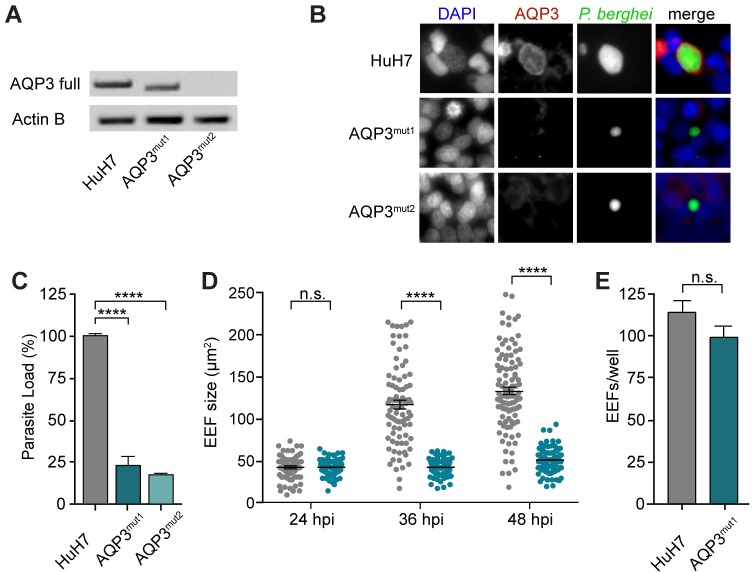
AQP3mut cells prevent the proper development of P. berghei exo-erythrocytic forms.(A) Full length AQP3 transcript PCR amplification of RNA collected from wild type HuH7 cells and AQP3 mutated cell lines produced by CRISPR/Cas9 genome editing, AQP3mut1 and AQP3mut2. A truncated AQP3 transcript was amplified in AQP3mut1 while AQP3mut2 did not produce any AQP3 mRNA. (B) AQP3 protein was not detected by immunostaining in AQP3mut1 or AQP3mut2 cell lines at 48 hpi. Images of cells infected with P. berghei and stained for PbHsp70 (green), HsAQP3 (red), and DAPI (blue). (C) Parasite load in AQP3mut1 and AQP3mut2 cells was significantly decreased by 77 ± 4.7% and 82 ± 0.24%, respectively (mean ± SEM; n = 3 independent experiments) (One-way ANOVA, Dunnett’s multiple comparison test). (D) Size of EEFs in HuH7 wild type cells (grey) and AQP3mut1 cells (blue) at 24, 36, and 48 hpi. EEF size was not significantly different at 24 hpi but was 65% and 64% smaller at 36 and 48 hpi, respectively, in AQP3mut1 compared to wild type cells (unpaired Student’s t-test; n > 100). (E) Number of EEFs was not significantly different in AQP3mut1 cells compared to wild type cells (p = 0.165, unpaired Student’s t-test; n = 5). ***p < 0.001 and ****p < 0.0001.